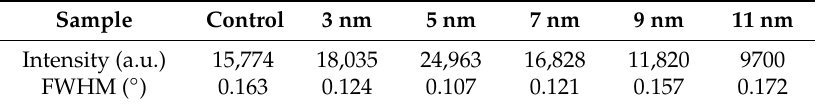
Table 1. Relevant information of the representative di ff raction peak at the (110) facet. Sample